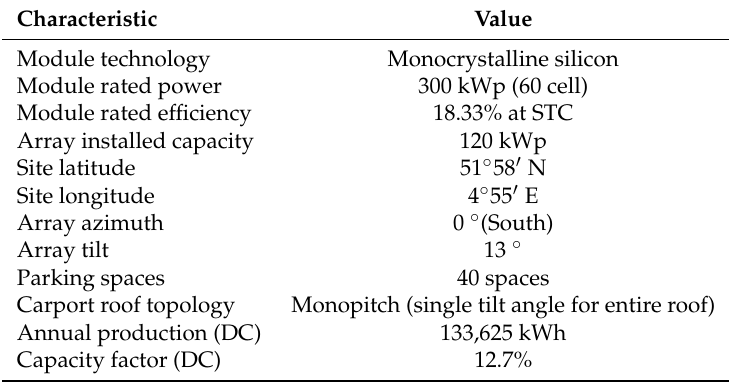
Table 1. Description of solar photovoltaic array